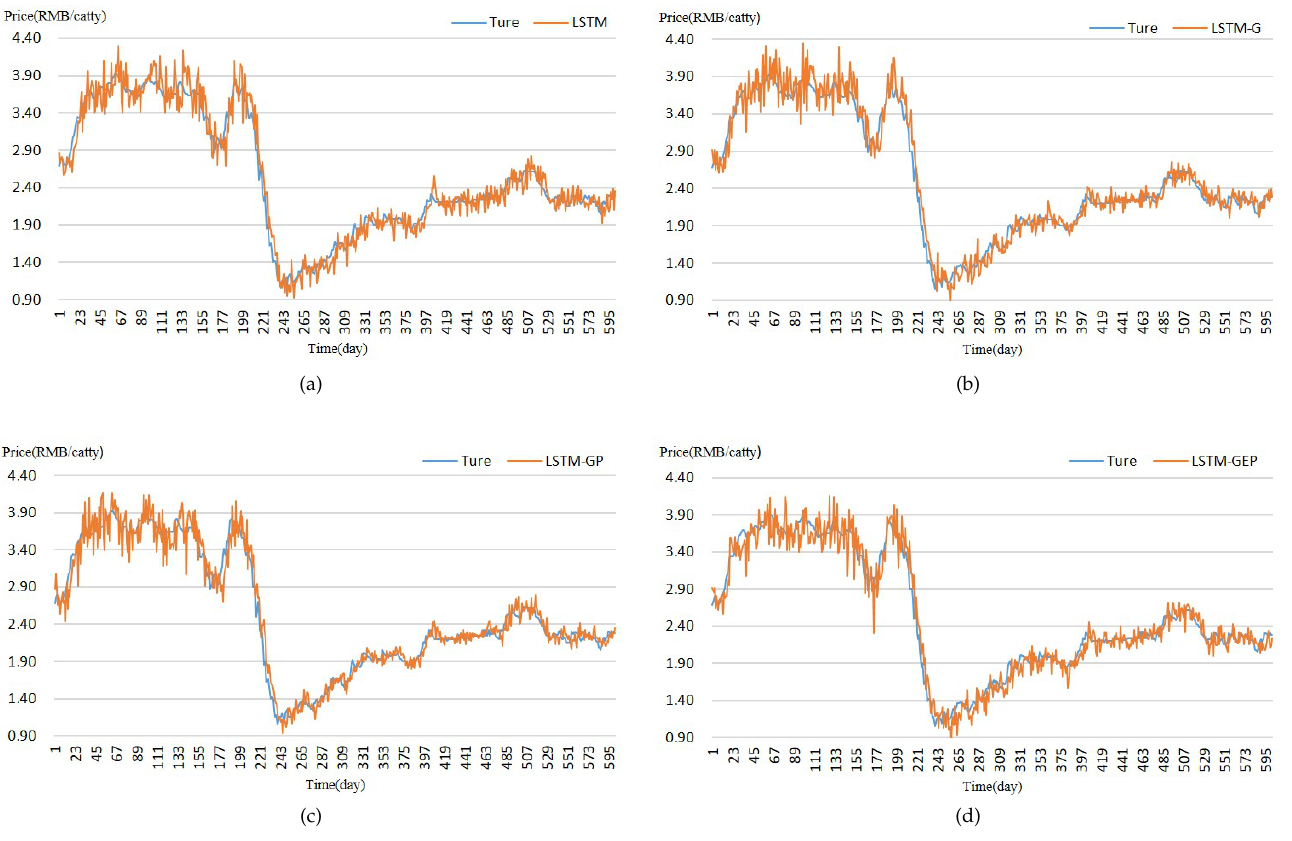
Figure 7. The prediction results of the models on the test set. ( a ) LSTM, ( b ) LSTM-G, ( c ) LSTM-GP, ( d )